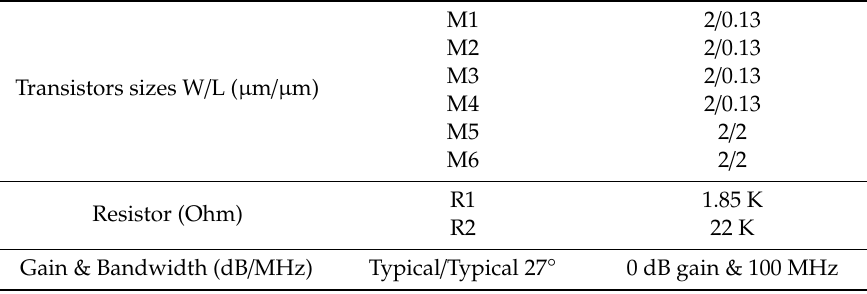
Table 7. Component sizes and simulated performance specifications.